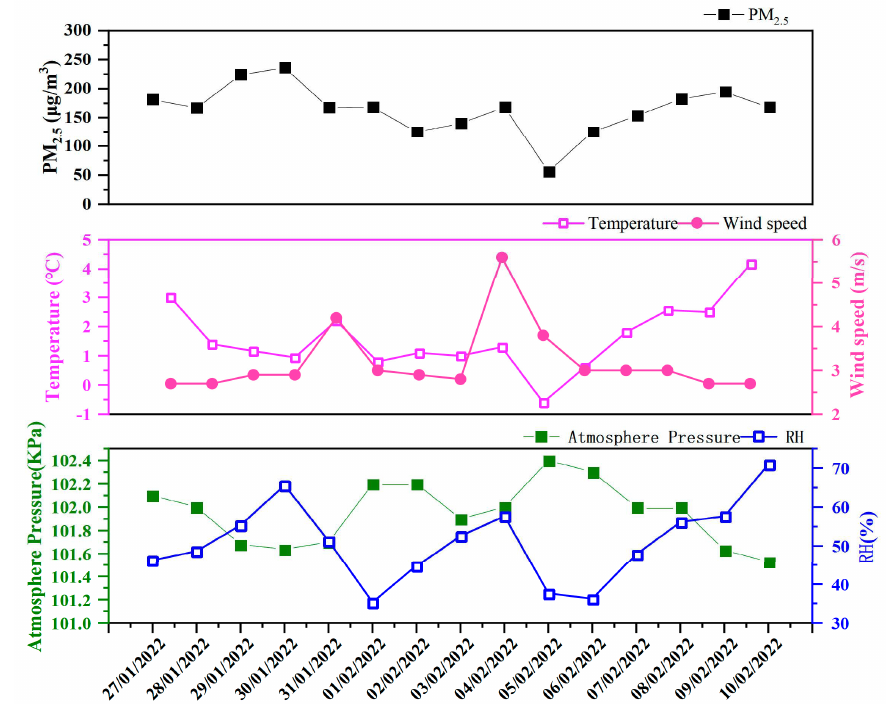
Figure 1. The distribution of PM 2.5 and meteorological factors during the sampling period. PM 2.5 was negatively correlated with air pressure and wind speed (<4 m/s), indicating that it contributed to the diffusion of PM 2.5 when the ground was controlled by a high pressure or when the wind speed was large [20]. PM 2.5 was positively correlated with relative humidity, reflecting that the high-humidity conditions in winter contributed to the accumulation of PM 2.5